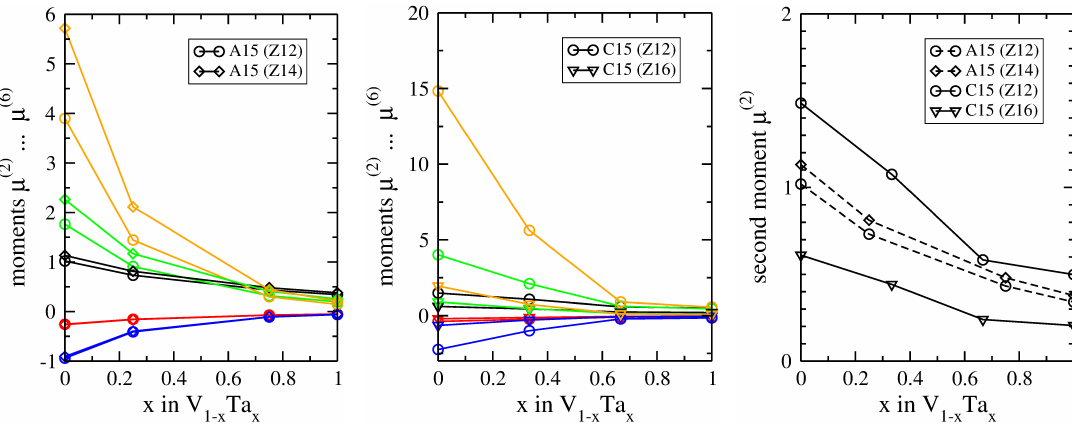
Figure 5. Influence of considerable atomic-size difference on moments of DFT-relaxed unit cells of A15 ( left ) and C15 ( middle ). Variation of second moment for different Wyckoff positions in A15 and C15 ( right ). (for color coding, see Figure